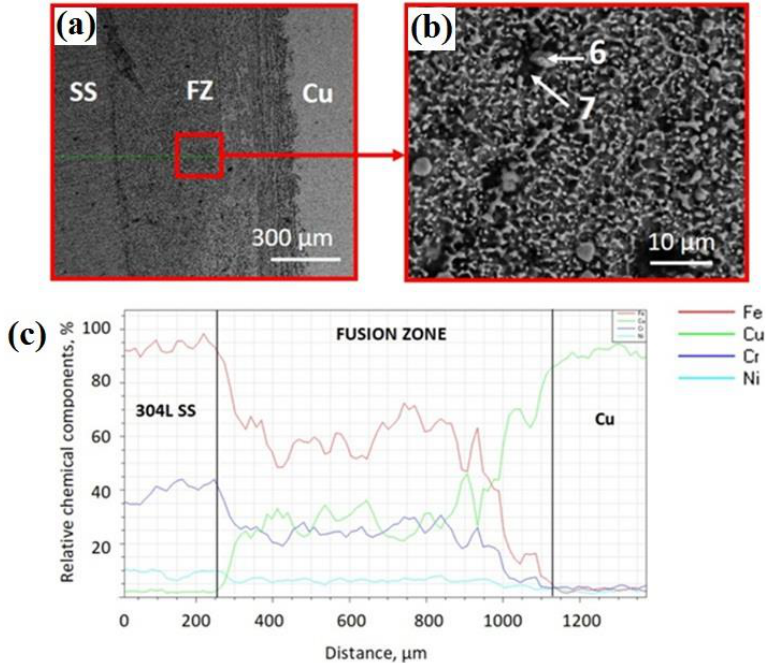
Figure 4. SEM images of the sample welded with a beam power of 3000 W (Sample 2): ( a ) SEM image of the obtained joint, ( b ) higher-magnification SEM image of the fusion zone (FZ), and ( c ) distribution of the elements across the welded joint studied by EDX. Table 2. Chemical composition of each point marked on SEM images of Sample 2. Element, wt.